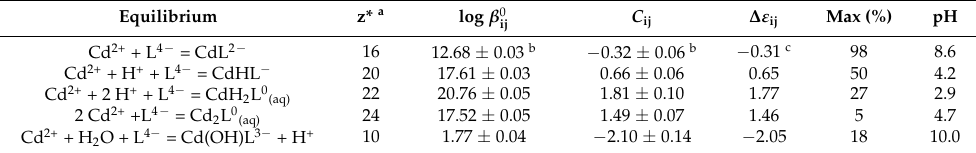
Table 6. Overall metal ligand complex formation constants, ionic strength dependence parameters (both in the molar, C ij , and in the molal concentration scale, ∆ ε ij ) and details on the formation percentages ( C Cd = 0.4 mmol dm − 3 ; C L = 0.97 mmol dm − 3 , I = 0.5 mol dm − 3 ) of Cd 2+ /GLDA 4 − species for the selected speciation model obtained in the pH range 2.0 < pH < 10.0 at T = 298.15 K and p = 0.1